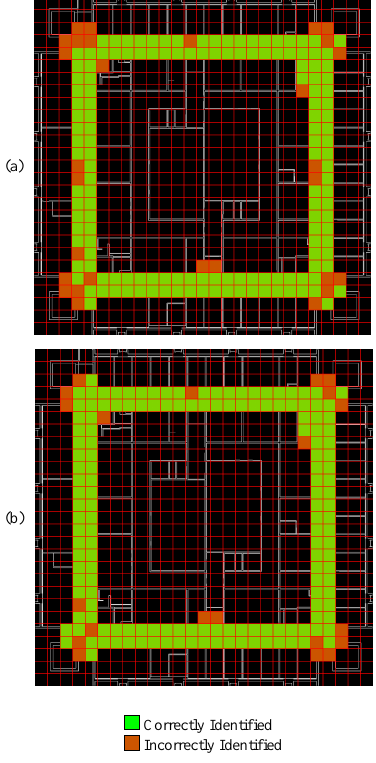
Figure 12. Maps for reference point identified using RNN, (a) manually collected dataset (b) AR assisted